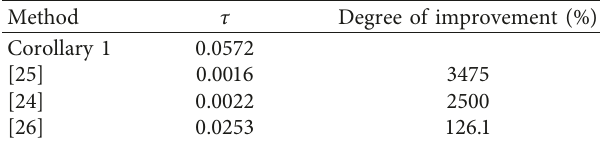
Table 3: Maximum value of the sampling period τ